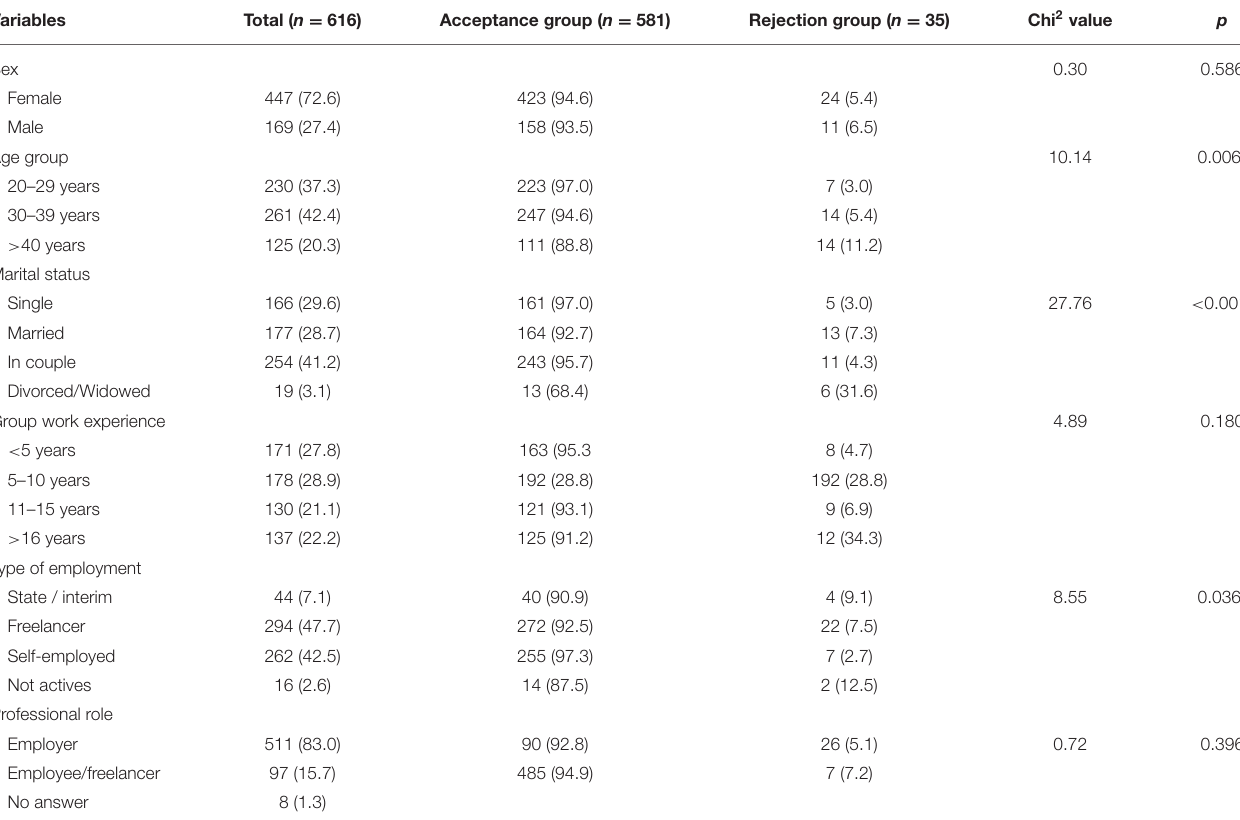
TABLE 5 | Profile of the physical therapist who accepts or rejects the COVID-19 vaccine.